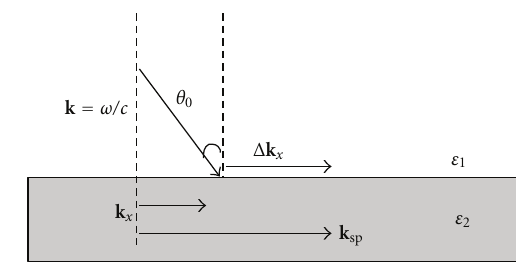
Figure 1: Dispersion relationship curve of SPs.